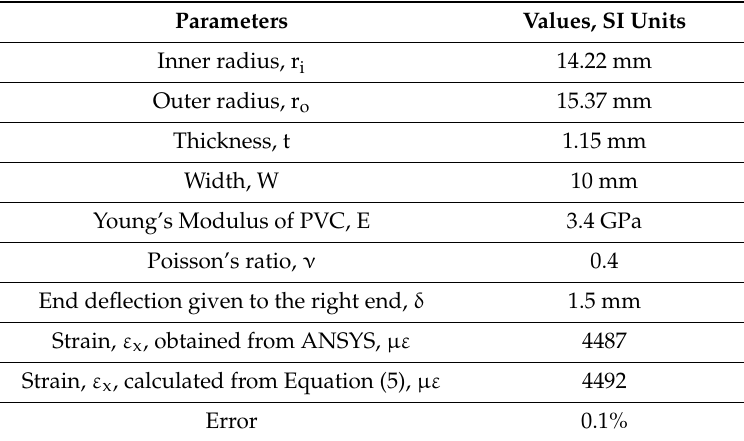
Table 1. Mechanical property and model